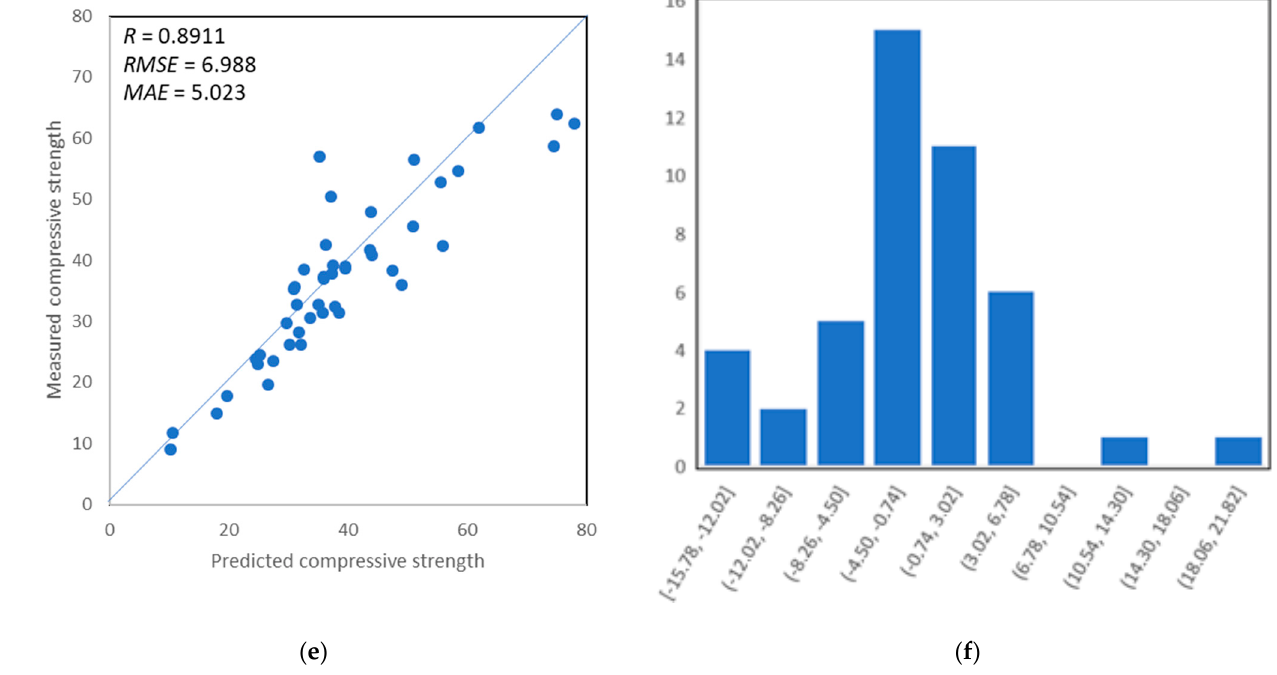
Figure 8. ( a ) Predictions vs. target data of training set; ( b ) error distribution of SVM model with prediction versus training set; ( c ) predictions vs. target data of validation set; ( d ) error distribution of SVM model with prediction versus validation set; ( e ) predictions vs. target data of testing set; ( f ) error distribution of SVM model with prediction versus testing set.